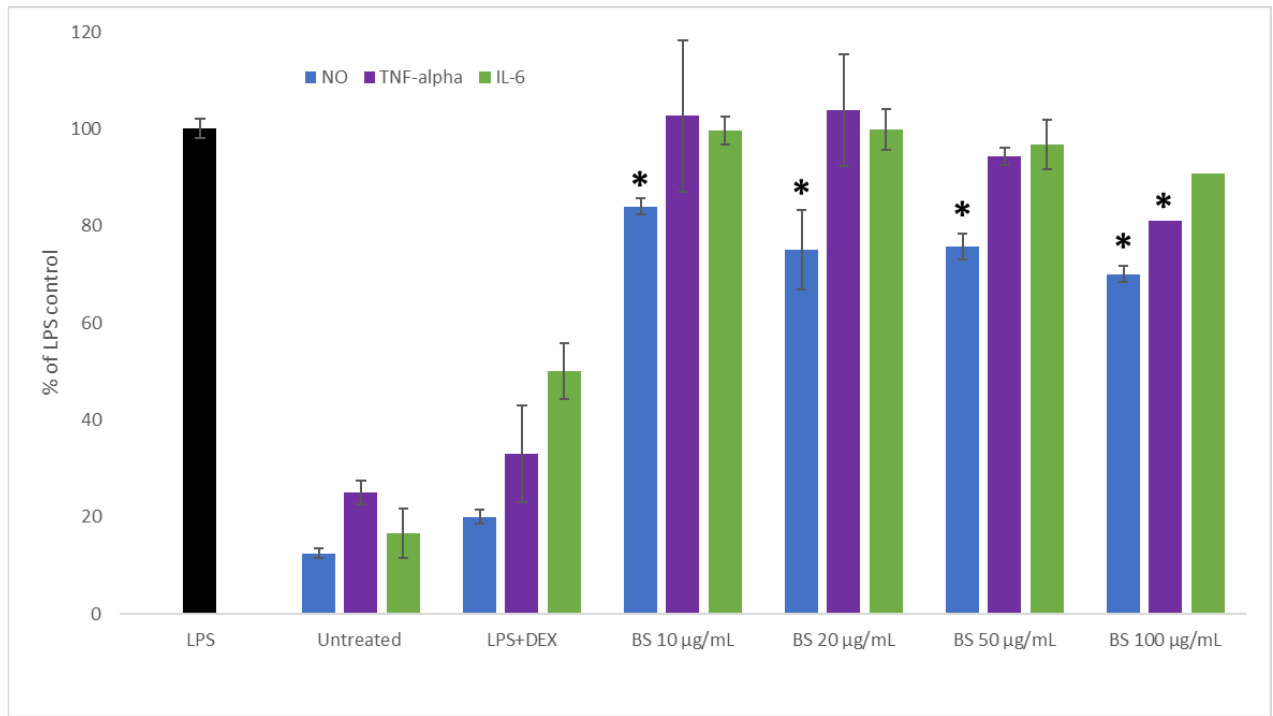
Figure 2. Effect of broccoli sprout extract (BS) on tumor necrosis factor-alpha (TNF-alpha), interleukin-6 (IL-6), and nitric oxide (NO) release in LPS-stimulated RAW 264.7 macrophages. RAW cells were pre-treated with 10, 20, 50, and 100 µg/mL of sprout extract for 1 h; afterwards, cells were incubated with (10 ng/mL) or without LPS (untreated) for the next 24 h. Dexamethasone (DEX) was used as a reference. Values are presented as the mean ± SD (standard deviation) of three independent experiments in triplicate. Statistical analyses were carried out using one-way ANOVA and Tukey’s post-hoc test with *: p < 0.05 against the LPS-stimulated